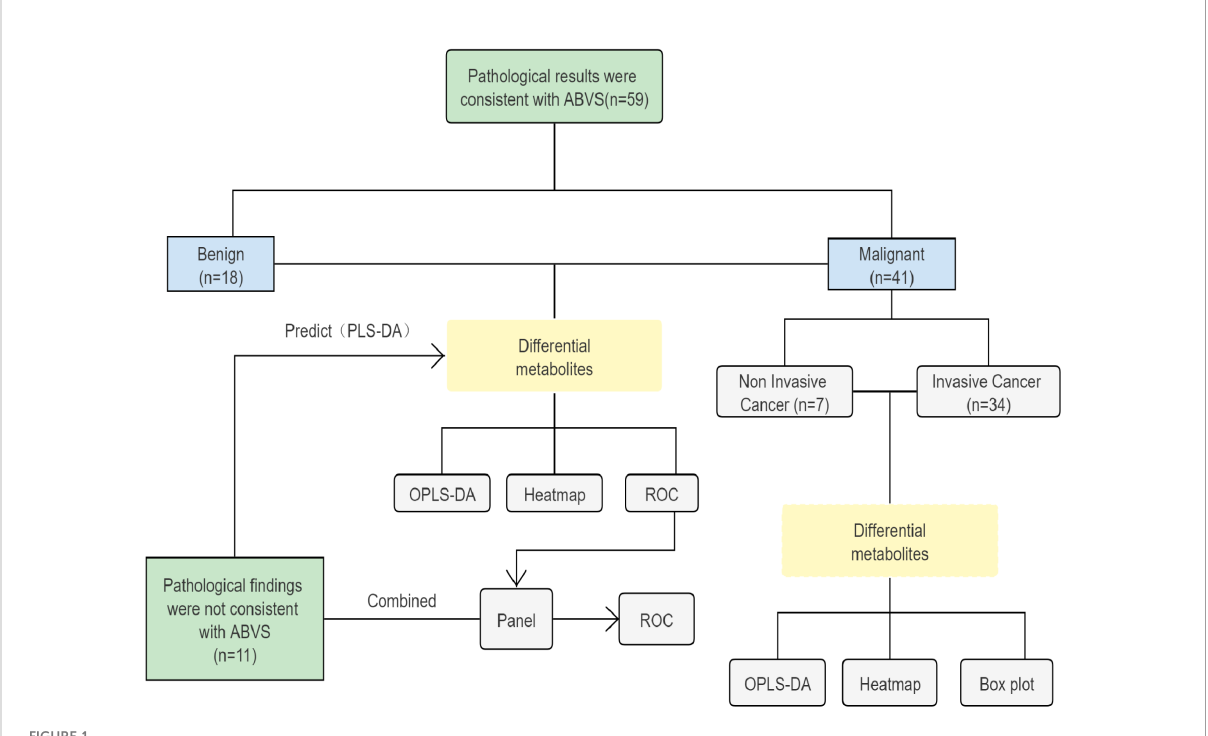
FIGURE 1 The design and work fl ow of this